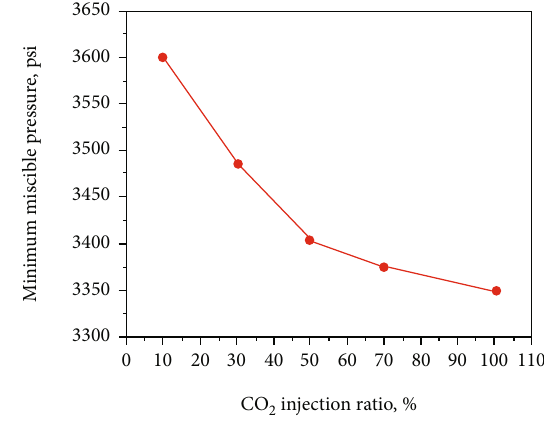
Figure 8: Minimum miscible pressure of the Bakken tight oil versus CO 2